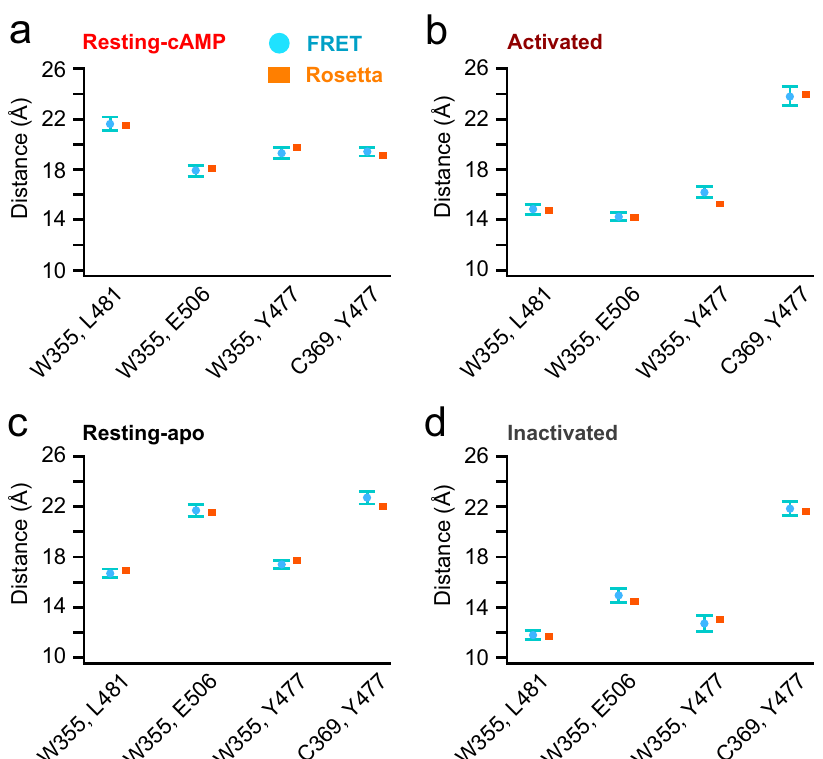
Fig. 5 Comparison of the measured distances from tmFRET and the corresponding distances from Rosetta models. a – d Comparison of the distances of FRET pairs measured from tmFRET (circle, mean ± s.e.m, n = 3 – 7) using the FCG relation in Fig. 4b and mean C β – C β distances of these FRET pairs in the 17 top scoring Rosetta models (square) based on the experimentally-determined distance constraints in four states: resting-cAMP ( a ), activated ( b ), resting- apo ( c ), and inactivated ( d ). The standard deviation of the C β – C β distances from the top 17 scoring Rosetta models for each state was less than 0.3